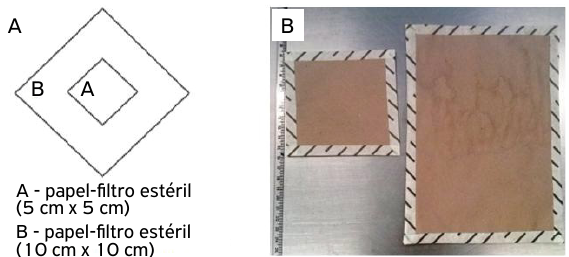
(B) cartão de esterilização utilizado para autoclavagem.